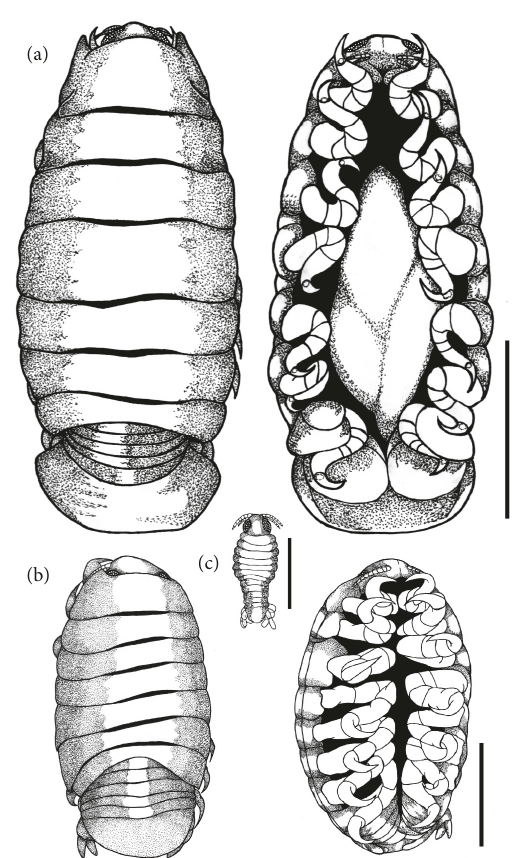
Figure 2: Cymothoa excisa collected from Lutjanus analis . Dorsal and lateral views of the female, respectively. Bar: 10 mm; (b) Dorsal and ventral views of the male. bar: 2 mm. (c) Dorsal view of manca. Bar: 0,02